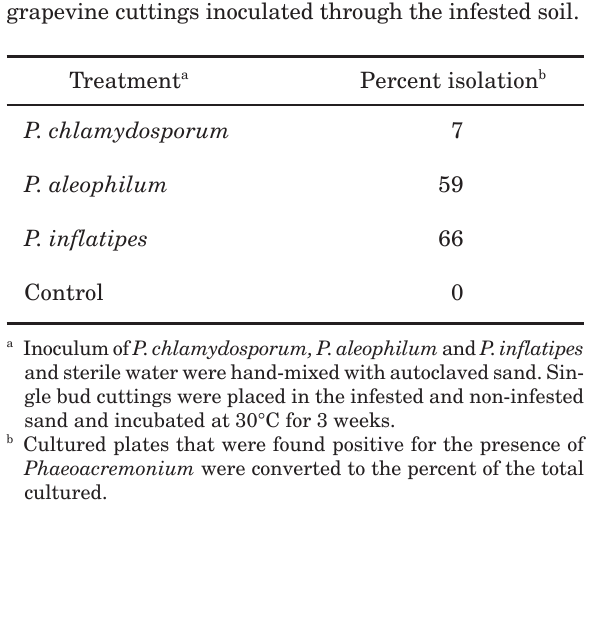
Table 1. Percent isolation of Phaeoacremonium